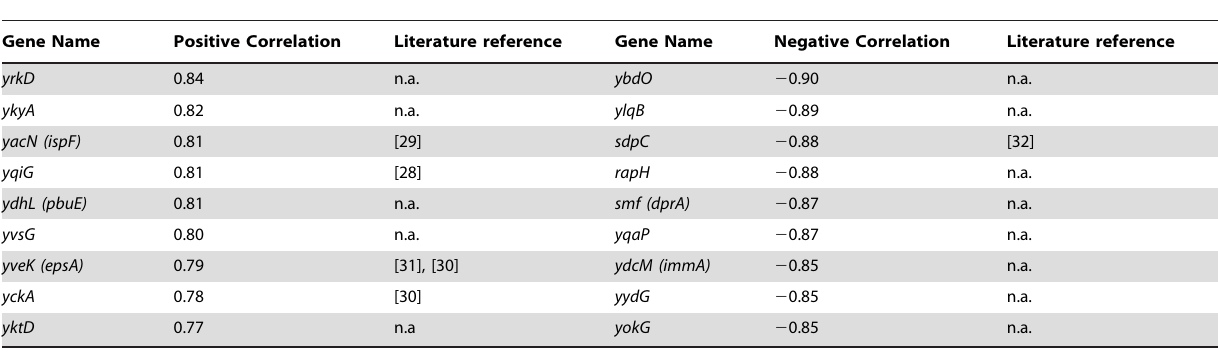
Table 1. Genes with expression profiles correlating with oxygen